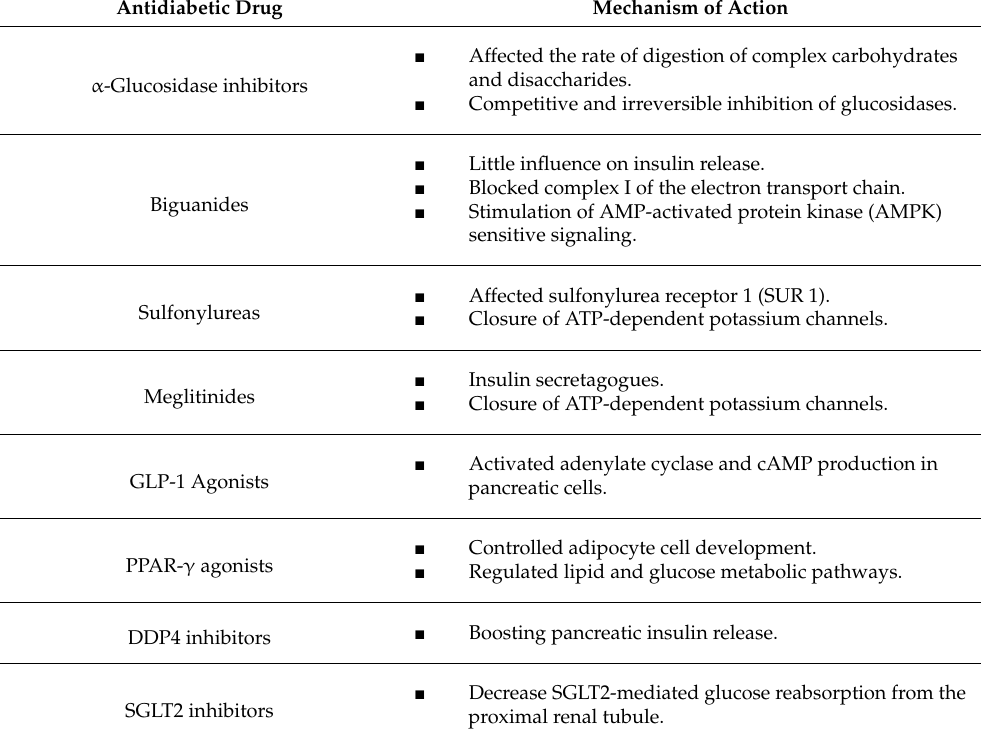
Table 1. Mechanisms of antidiabetic